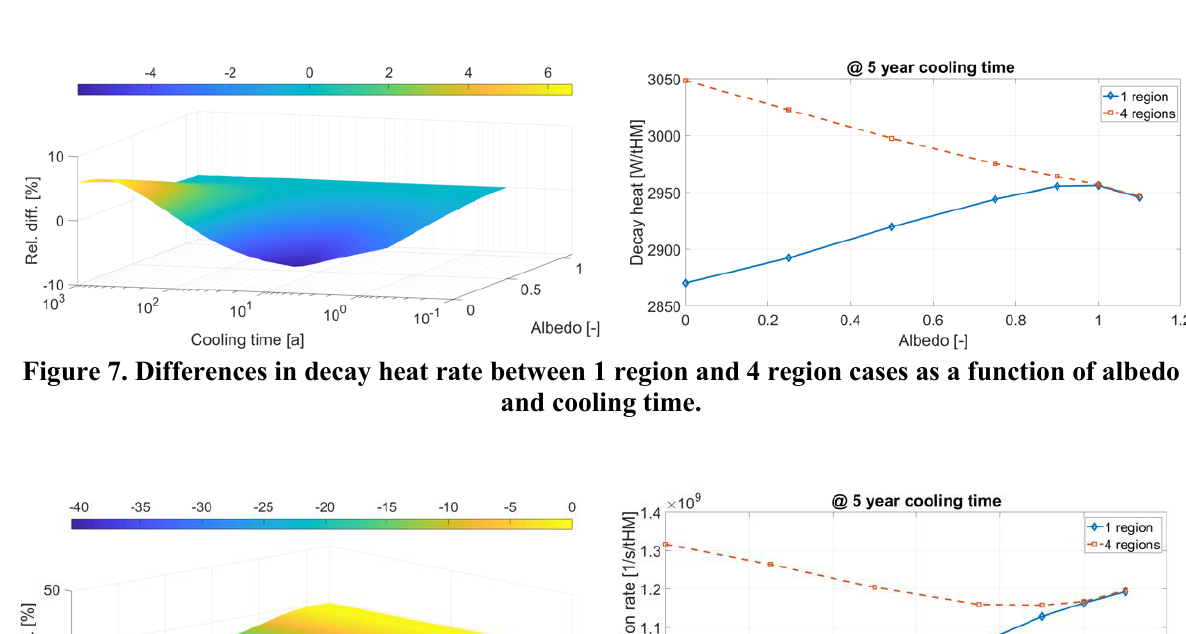
Figure 6. 244 Cm mass as a function of irradiation + subsequent cooling time for different albedo boundary conditions.